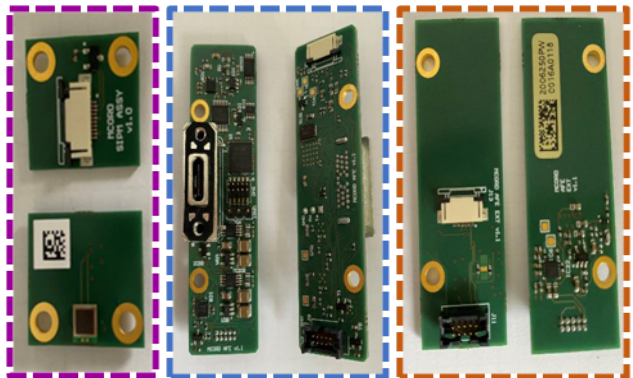
Figure 5. MCORD AFE electronic boards viewed from both sides. SiPM socket with installed SiPM detector ( left , purple), main AFE ( centre , blue), and external AFE ( right , orange).